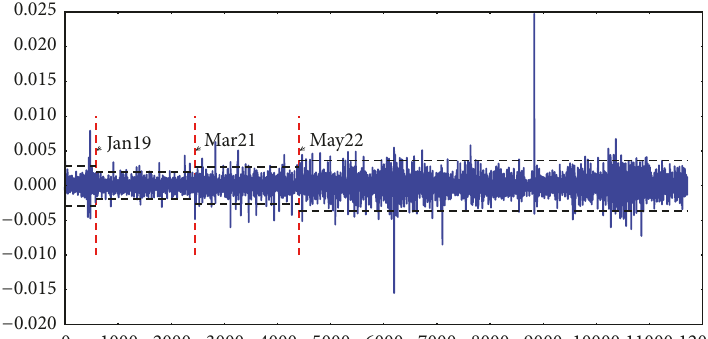
Figure 3: Changes in the 1-minute returns in the Chinese Stock Market . The CUSUM test finds 3 structural changes, which can divide the entire return series into 4 phases. The first phase is from January 3 to January 18, the second phase is from January 19 to March 20, the third phase is from March 21 to May 21, and the fourth phase is from May 22 to December